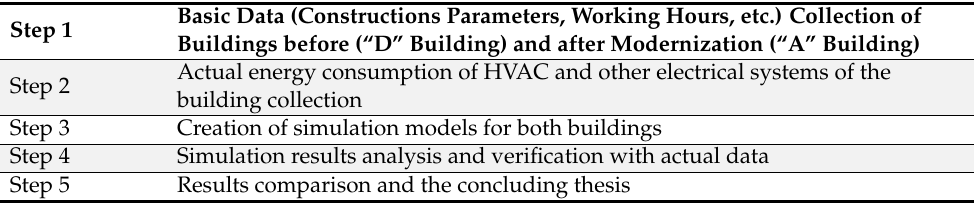
Table 1. Consistency of research methodology.